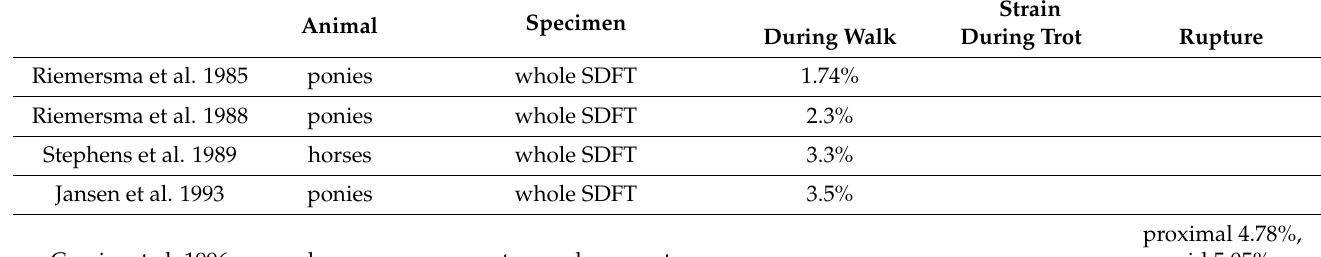
Table 1. Strains of the superficial digital flexor tendon (SDFT) reported in literature. Animal